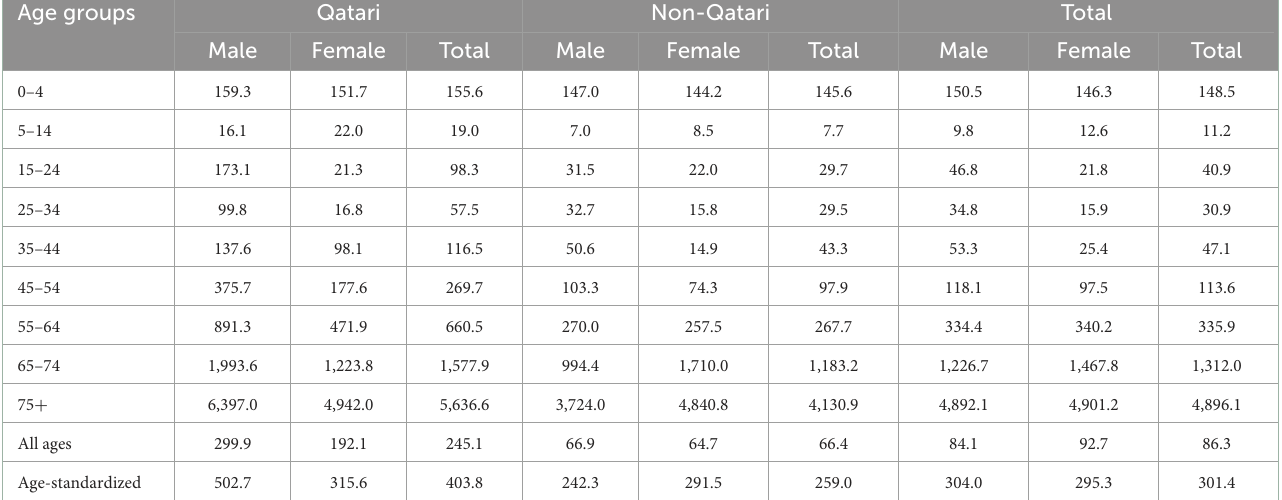
TABLE 2 Mortality rates per 100,000 population in Qatar by age-group, sex and nationality, 2018. Age groups